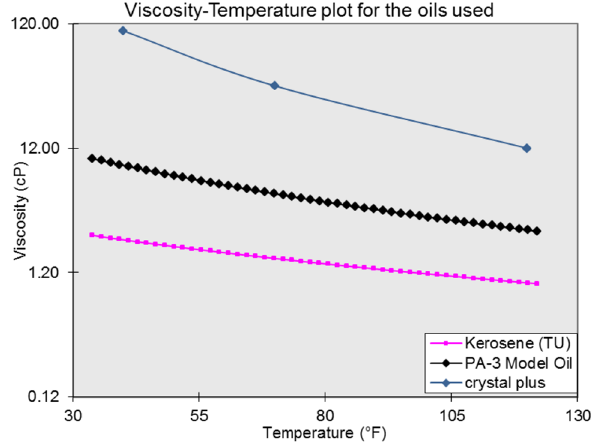
Fig. 11 Viscosity–temperature plot for the oils used to make hydrates